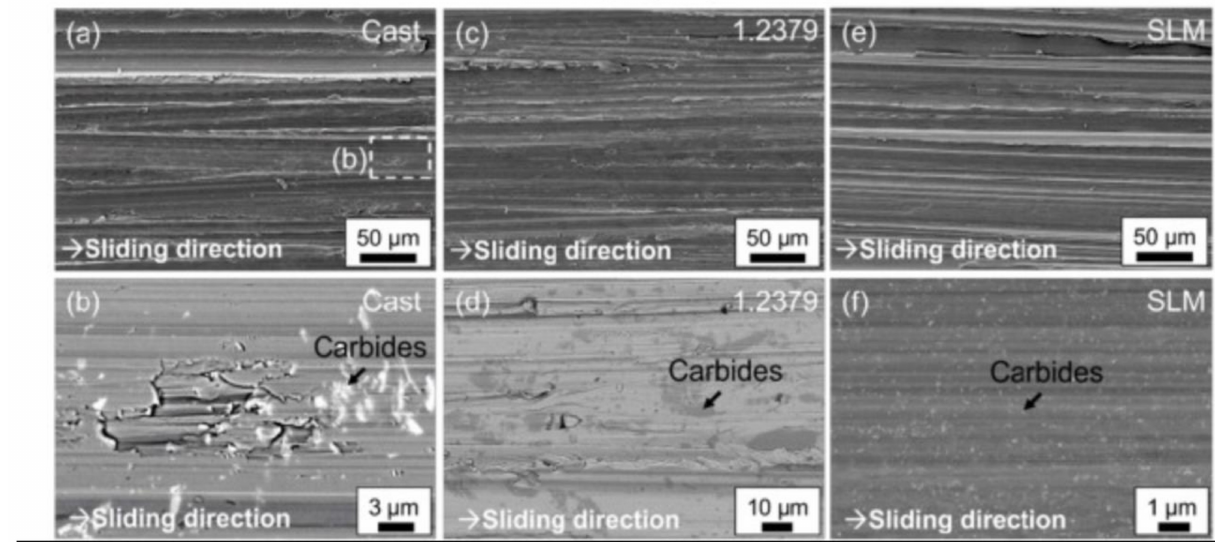
Figure 8. The SEM images of the wear tracks for ( a , b ) FeCrMoVC steel, ( c , d ) 1.2379 steel, and ( e , f ) SLM FeCrMoVC steel [100] Copyright 2022